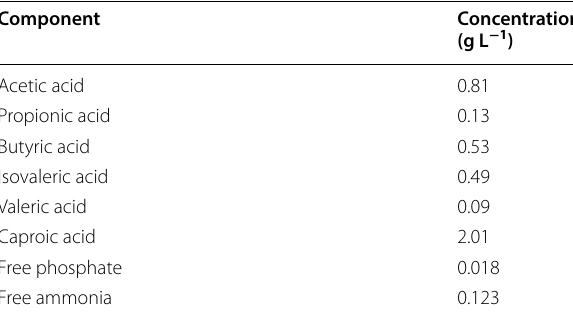
Table 1 Measured concentrations of key components of the anaerobic digest used in shake flask batch cultures of E.